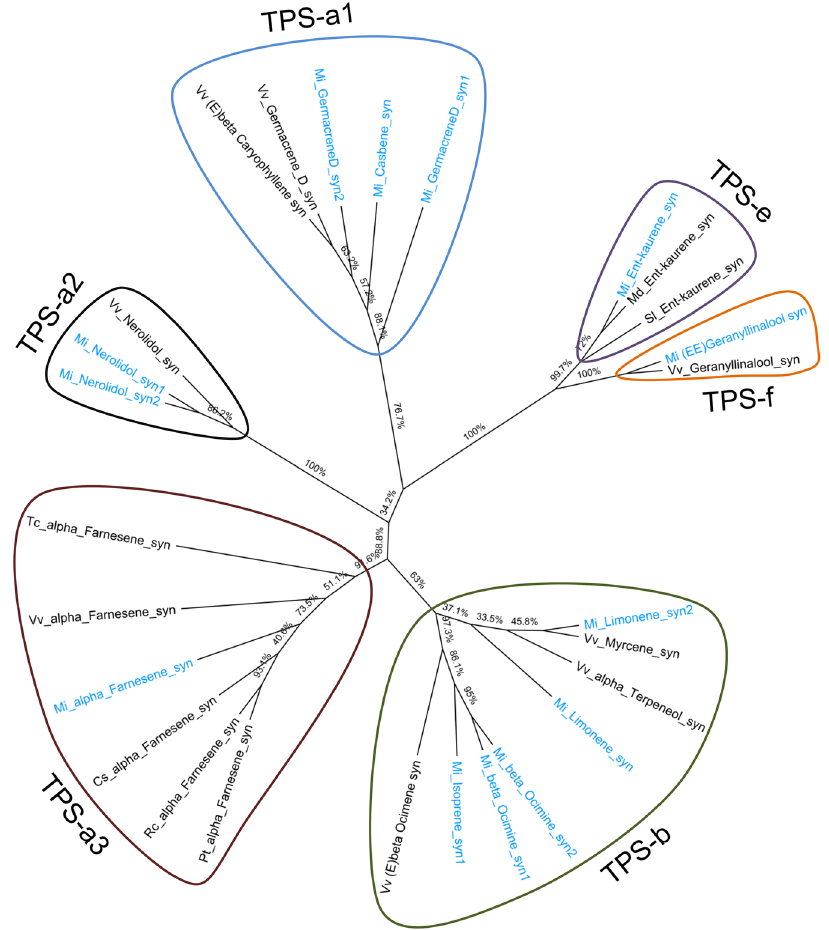
Figure 4. Cladogram representing phylogenetic analysis of proteins encoded by various terpene synthases identified in the present study (blue color) along with the terpene synthases from other Angiosperm plants (black color) using the neighbor-joining method. The node label is composed of two letters representing botanical name of the plant followed by name of the enzyme. Details of the plant species, enzyme and NCBI accession numbers in parenthesis are as follows Vitis vinifera _(E)-beta-caryophyllene synthase (ADR74192.1), Vitis vinifera _germacrene D synthase (ADR74198.1), Vitis vinifera _nerolidol synthase (ADR74211.1), Vitis vinifera _(E,E)-geranyl linalool synthase (ADR74219.1), Malus domestica _ent-kaurene synthase (AFG18184.1), Solanum lycopersicum _ent-kaurene synthase (AEP82778.1), Vitis vinifera _(E)-beta-ocimene synthase (ADR74204.1), Vitis vinifera _Alphaterpeneol synthase (ADR74202.1), Vitis vinifera _myrcene synthase (NP_001268009), Citrus sinensis _alpha-farnesene synthase (XP_006467948.1) Populus trichocarpa _alpha- farnesene synthase (XP_002317269.2), Ricinus communis _alpha-farnesene synthase (XP_015574261.1), Theobroma cacao _alpha-farnesene synthase (EOY28527.1) and Vitis vinifera alpha _farnesene synthase